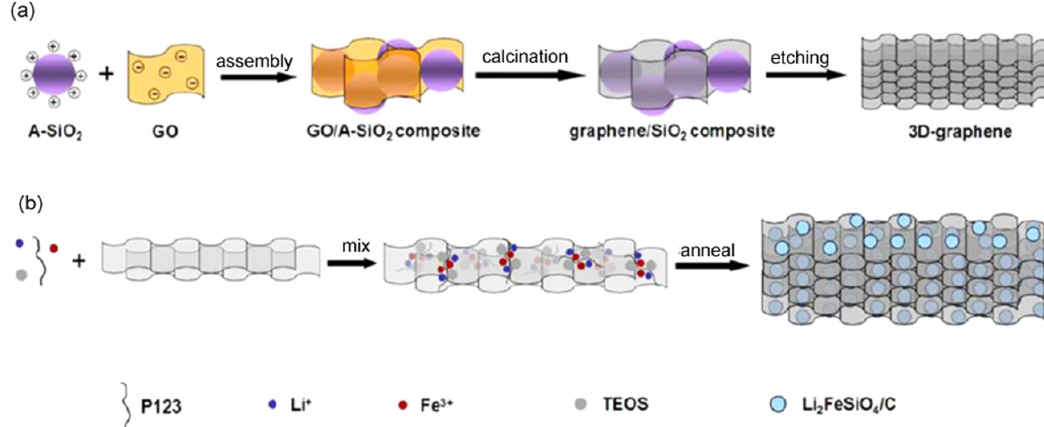
Figure 8. Illustrations of the synthesis procedures of ( a ) the 3D porous graphene and ( b ) the graphene/Li 2 FeSiO 4 /C composite. Reproduced with permission from [49]. American Chemical Society, 2014.